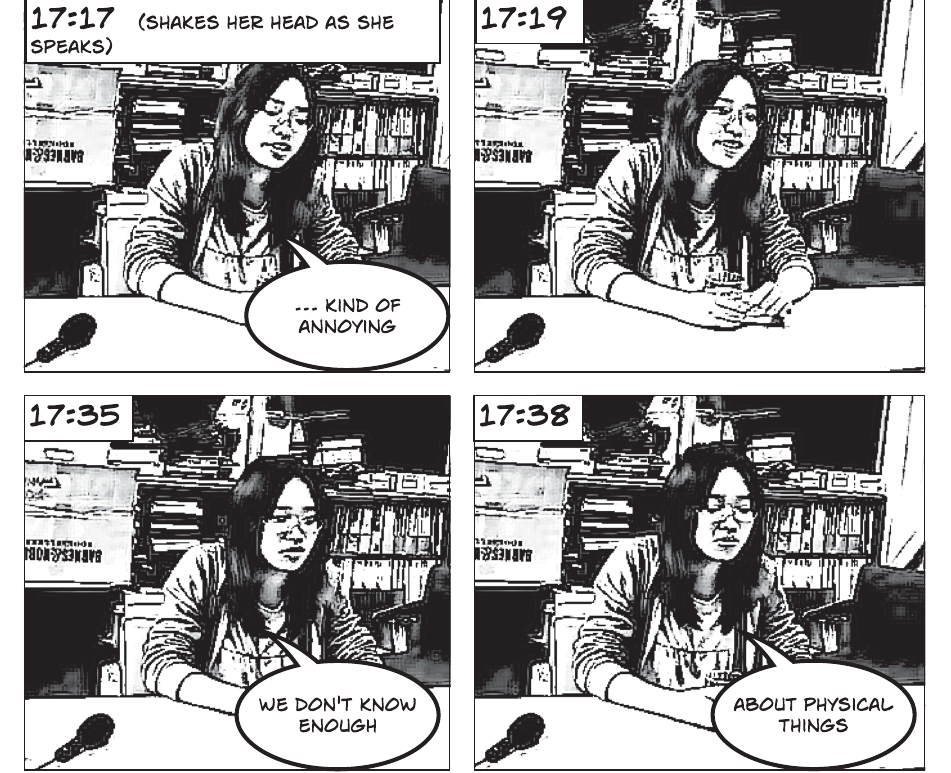
FIG. 4. The panels show the range of Judy ’ s facial expressions in episode 2 as she discusses the conceptual questions being